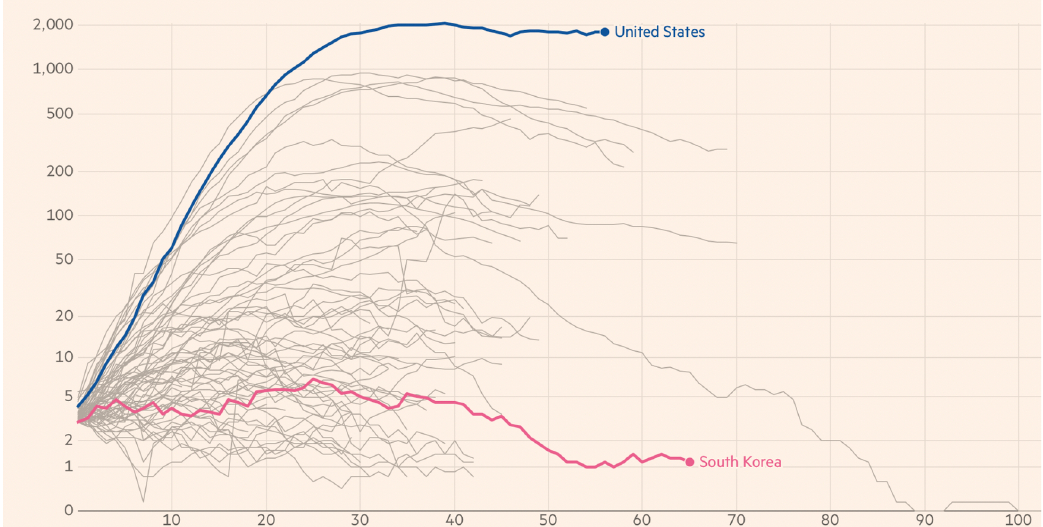
Figure 2. New deaths attributed to Covid-19 in United States and South Korea. (Seven-day rolling average of new